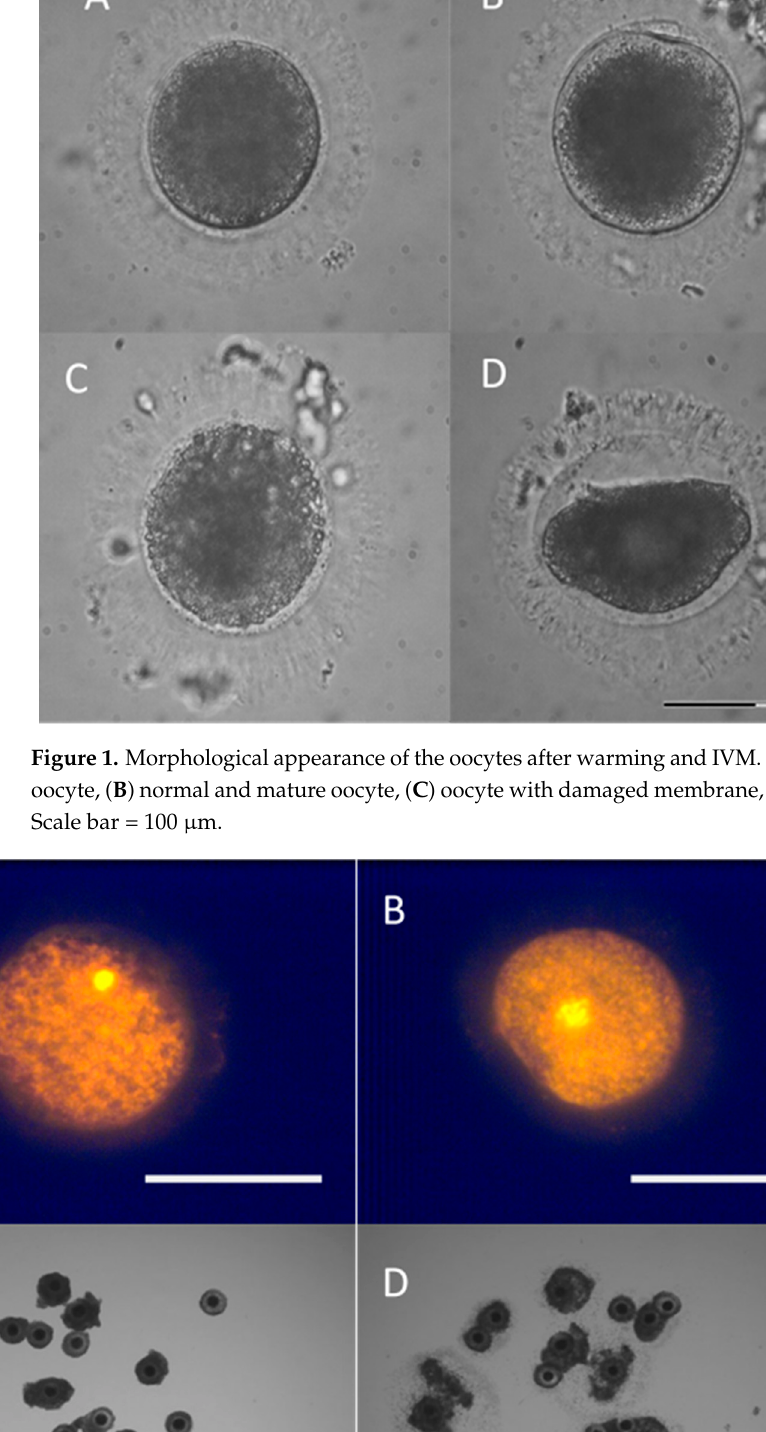
No significant differences were found between the groups. Bold: the average outcome of all of tube material.